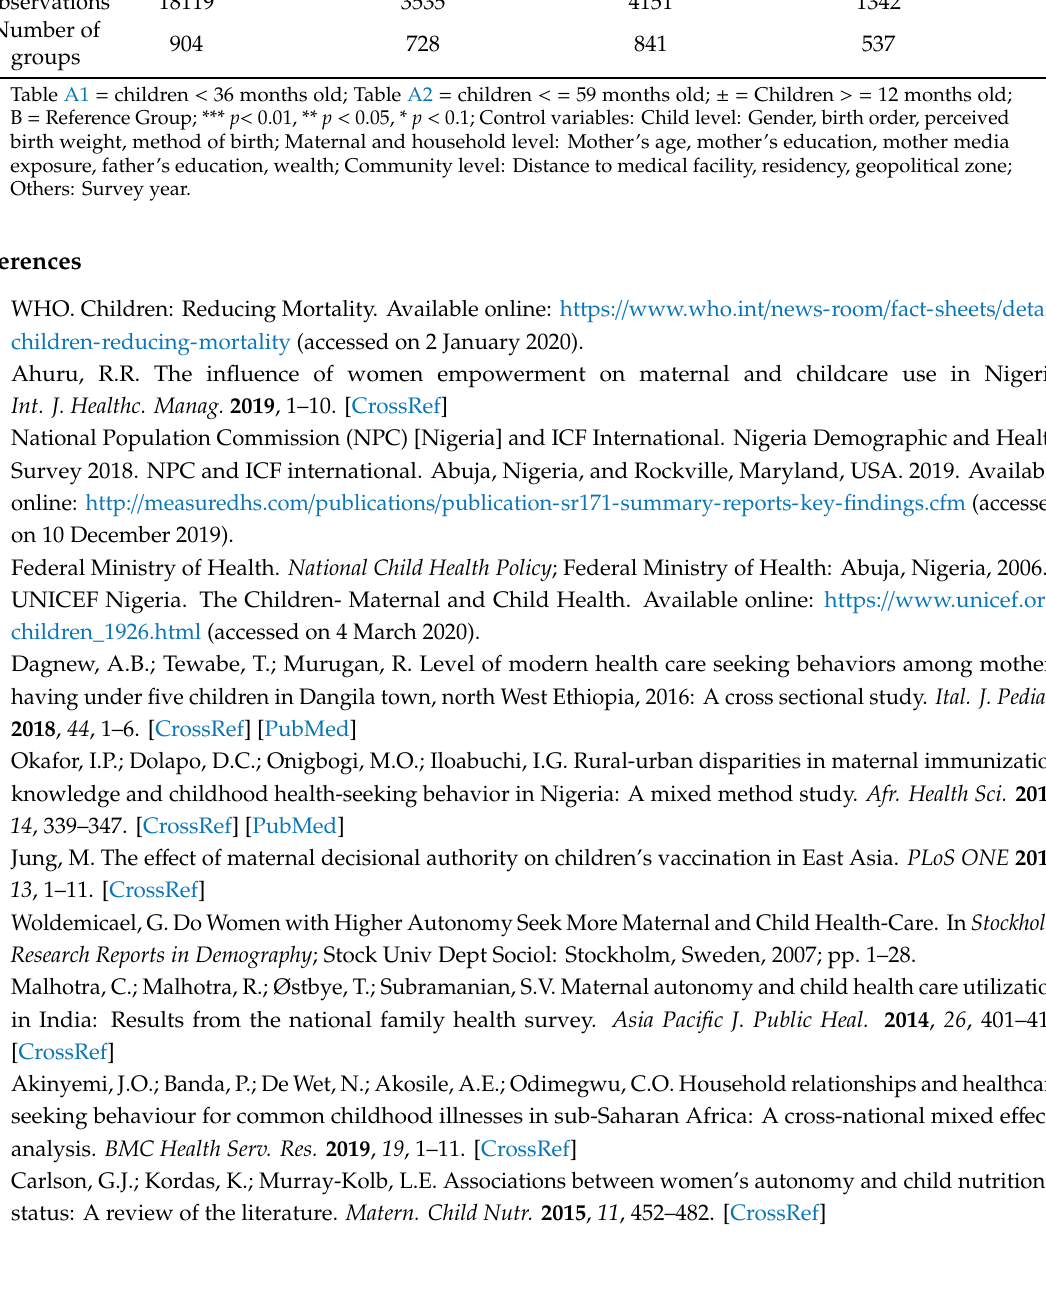
Table A1 = children < 36 months old; Table A2 = children < = 59 months old; ± = Children > = 12 months old; B = Reference Group; *** p < 0.01, ** p < 0.05, * p < 0.1; Control variables: Child level: Gender, birth order, perceived birth weight, method of birth; Maternal and household level: Mother’s age, mother’s education, mother media exposure, father’s education, wealth; Community level: Distance to medical facility, residency, geopolitical zone; Others: Survey